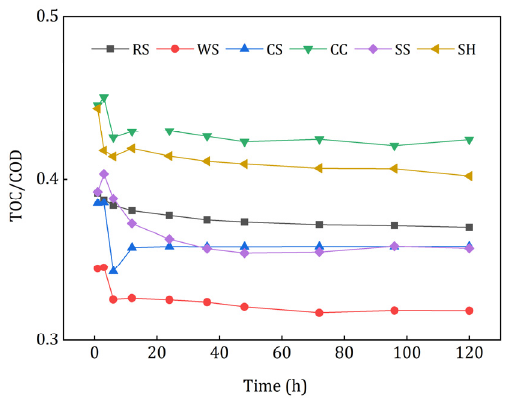
Figure 4. TOC/COD of the investigated agricultural wastes.